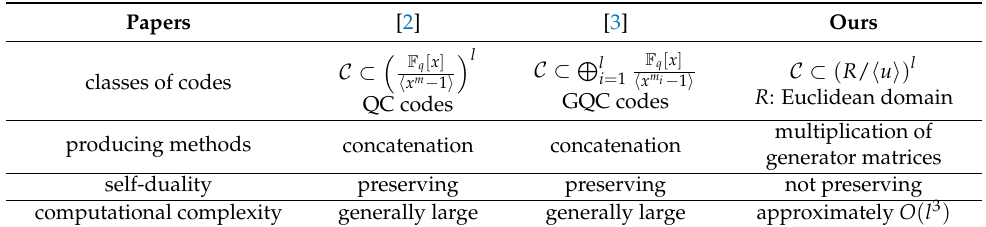
Table 1. Comparison of various methods which produce a code mod u = u 1 u 2 from codes mod u 1 and mod u 2